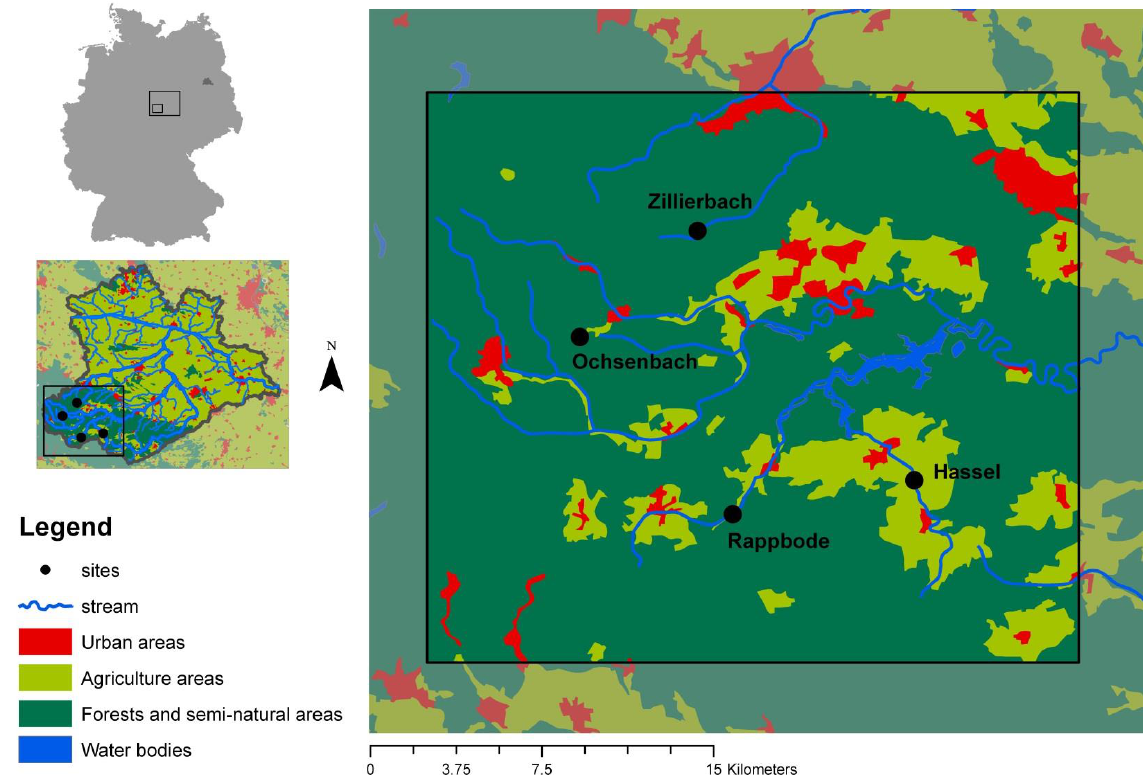
Figure 1 Fig. 1. Map of the investigation area with indicated sampling stations and land-use